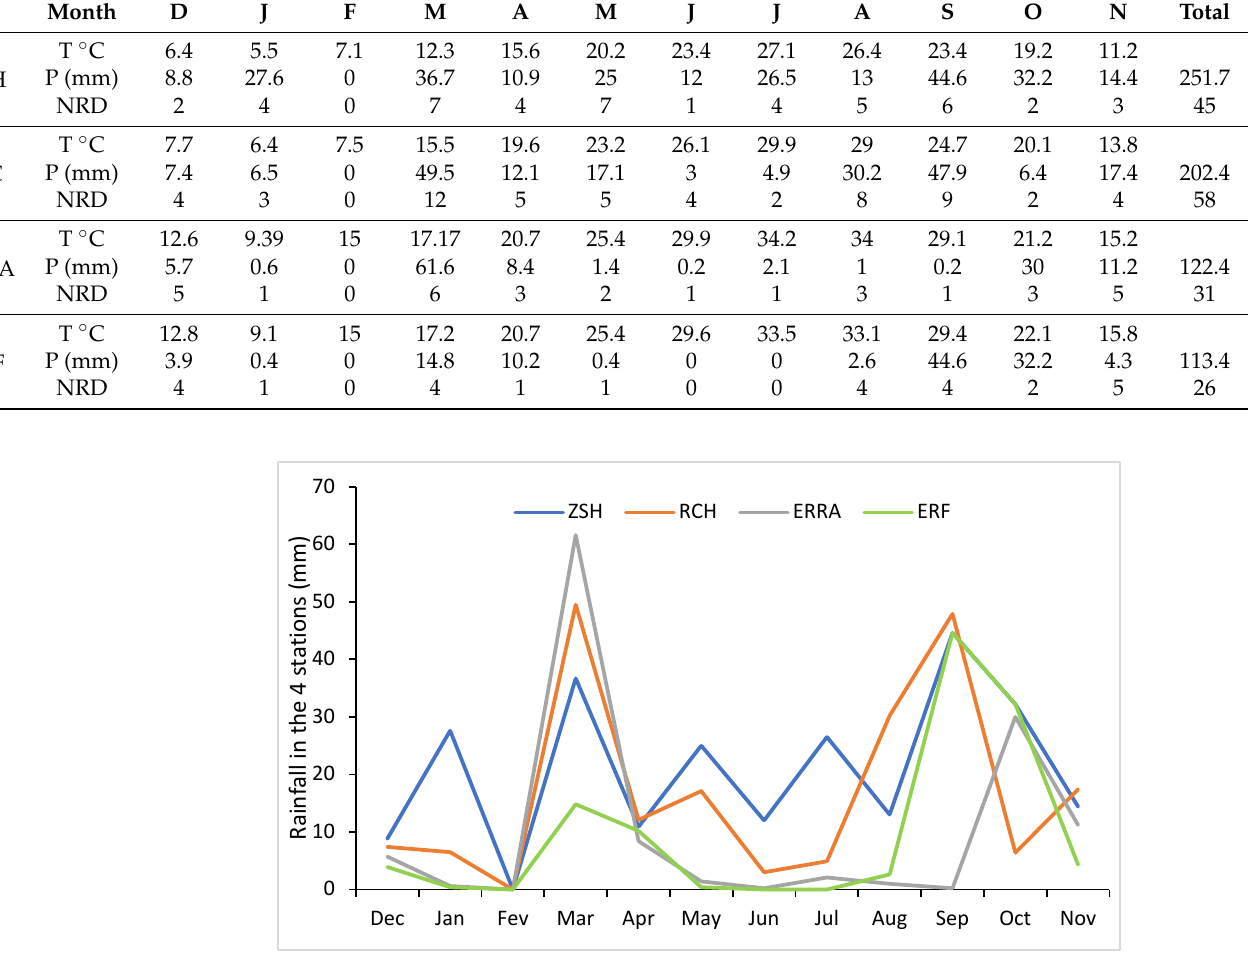
Figure 6. Variation in monthly rainfall at the four sampling stations (period December 2019–No-